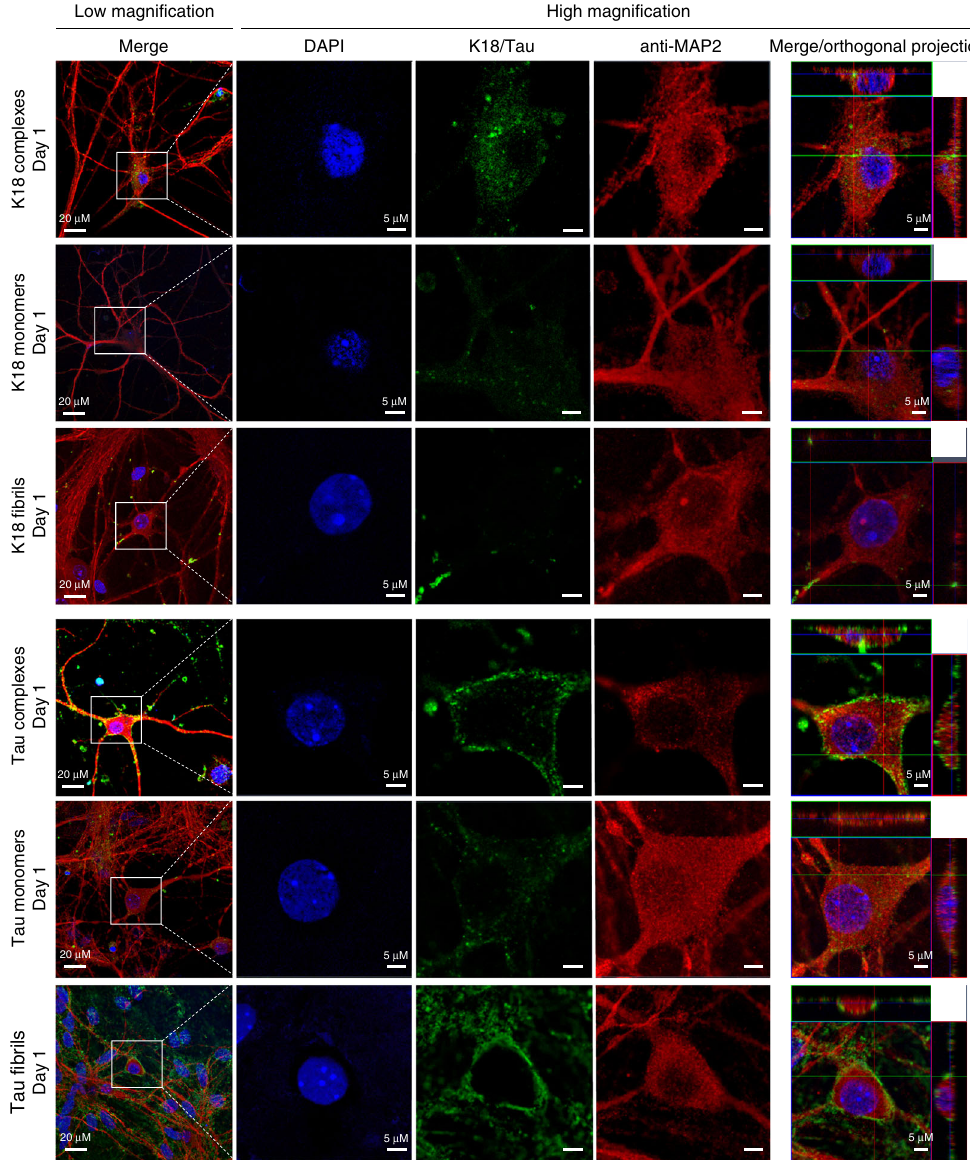
Fig. 6 Neuronal internalization of Tau and K18 monomers, fi brils and protein/phospholipid complexes. Hippocampal primary neurons were treated with PBS, 1 µ M Tau or Oregon Green-labeled K18 (K18-OG) protein/phospholipid complexes for 1 day and processed for immunocytochemistry. From left to right: overview image, DAPI staining to show the nucleus (blue), K18-OG or staining with anti-Tau antibody Tau13 (green), staining with anti-MAP2 antibody identifying neurons (red), and orthogonal projections. In neurons treated with protein/phospholipid complexes containing K18-OG, K18 localizes to the plasma membrane and is internalized by primary neurons after 1 day of treatment, as evidenced by the co-staining with MAP-2. In neurons treated with monomeric K18-OG, K18 is internalized and diffuse in the cytoplasmic compartment and in small punctae after 1 day of treatment. In neurons treated with K18-OG fi brils, K18 localizes to the membrane in the form of large punctae that are internalized by primary neurons after 1 day of treatment. In neurons treated with Tau/phospholipid complexes, Tau localizes to the plasma membrane and is internalized after 1 day of treatment. In neurons treated with monomeric Tau, Tau is internalized and present diffuse in the cytoplasmic compartment and in small punctae after 1 day of treatment. In neurons treated with sonicated Tau fi brils, Tau localizes to the plasma membrane and is not internalized at 1 day post-treatment. The scale bars are 20 µ m (low magni fi cation) and 5 µ m (high magni fi